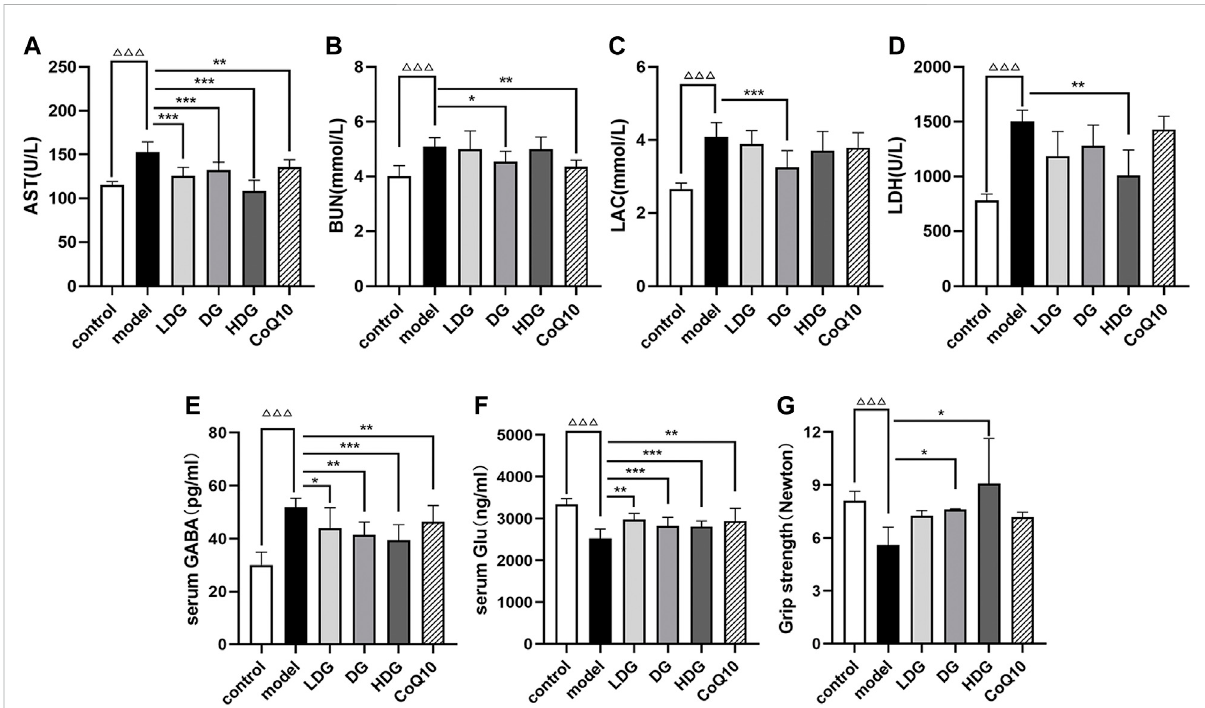
FIGURE 4 Effects of KPLD on peripheral fatigue and serum GABA and Glu levels in rats. Serum levels of AST (A) , BUN (B) , LAC (C) and LDH (D) were measuredwith anautomaticbiochemicalanalyzer. TheexpressionlevelsofGABA (E) andGlu (F) inratserum weretestedbyELISAkits.Gripstrength test wasperformed to detect skeletal muscle fatigue of rats (G) . Data wereexpressedas (mean ± SD), ΔΔΔ p < 0.001 vs. control group; * p < 0.05, ** p < 0.01, *** p < 0.001 vs. CF model group ( n =